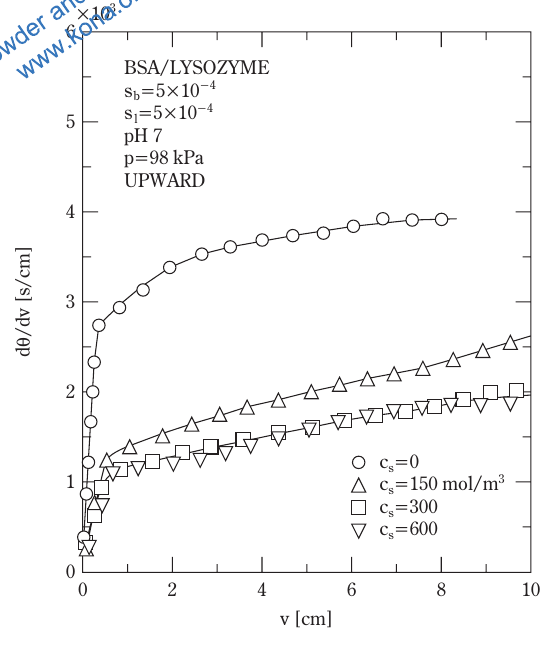
Fig. 24 Effect of salt addition on filtration rate at pH